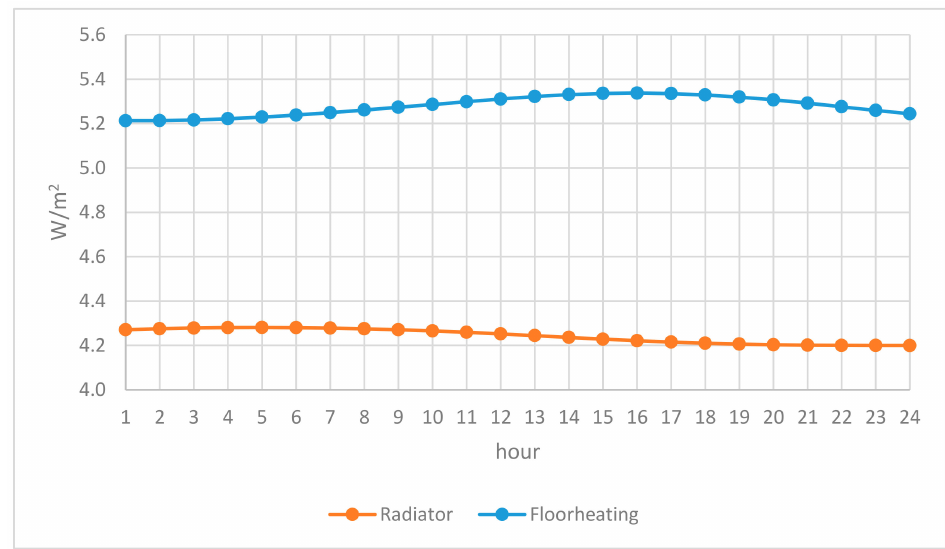
Figure 7. Floor transmission heat loss profile for the studied BBR building with radiator and floor heating system on the design day.